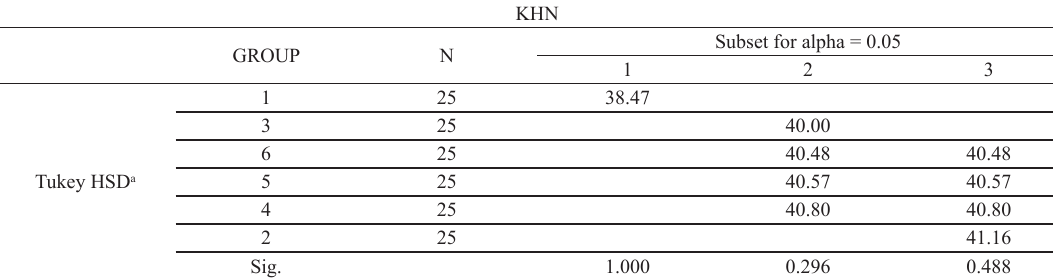
Table 5 - Means of Knoop microhardness (KHN) of groups in homogeneous